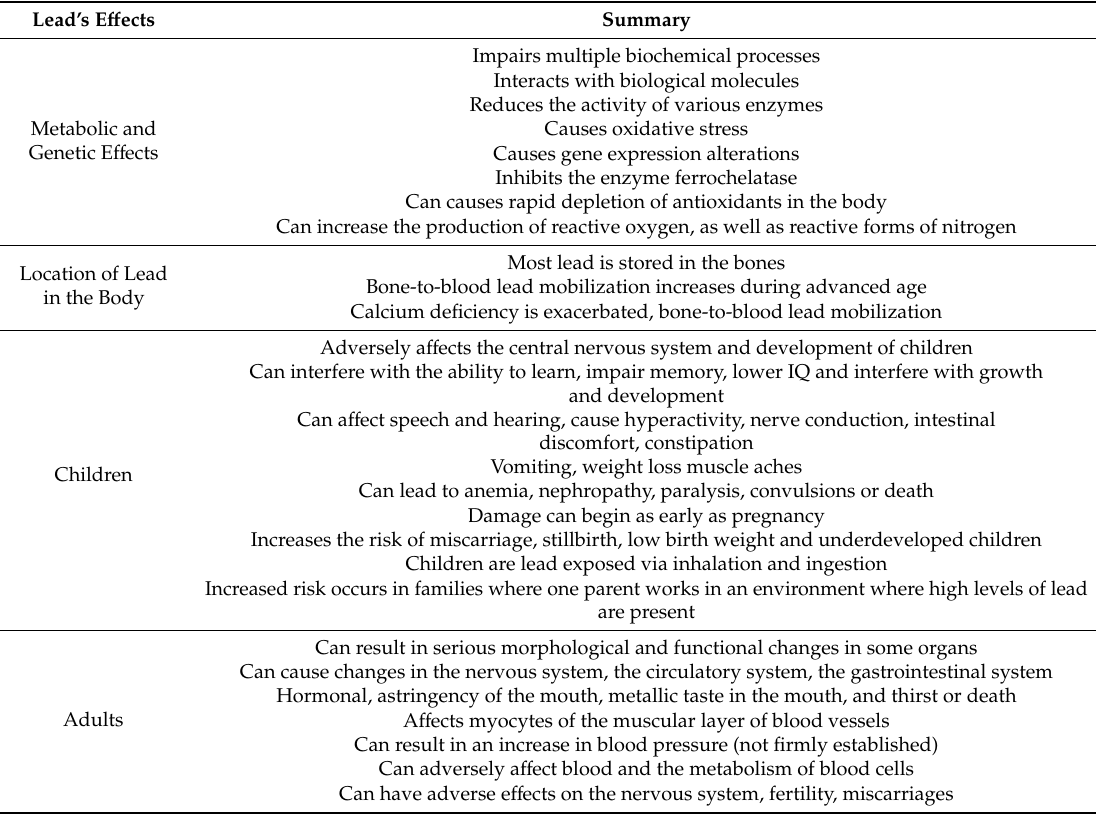
Table 2. The e ff ects of Lead—a